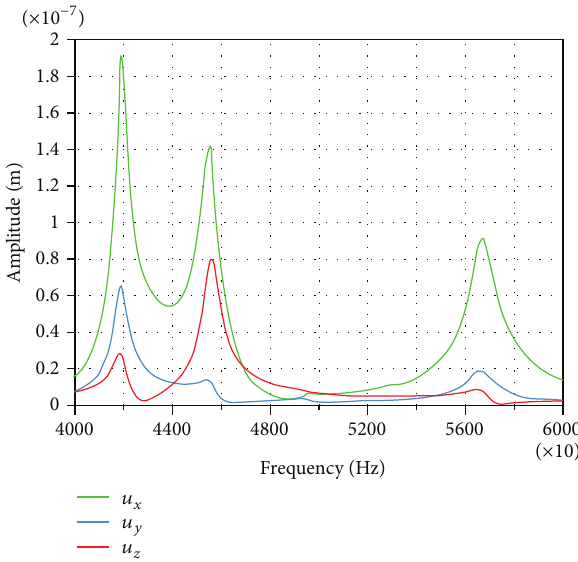
Figure 6: The amplitude-frequency characteristic of the contact point oscillation.